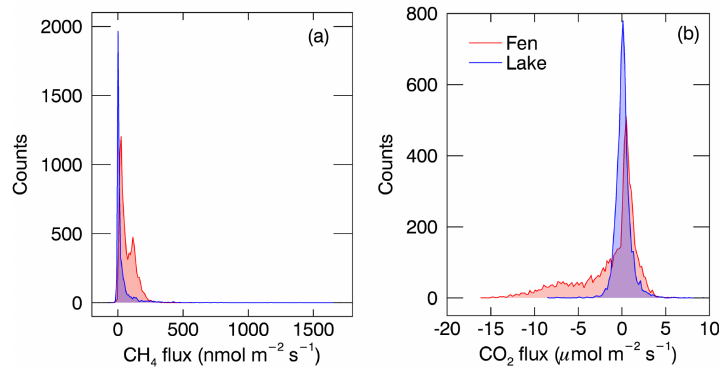
Figure C1. Probability density functions of (a) the measured CH 4 fluxes (bin size 10nmolm − 2 s − 1 ) and (b) the measured CO 2 fluxes (bin size 0.2µmolm − 2 s − 1 ) from the fen and from the lake during the entire measurement